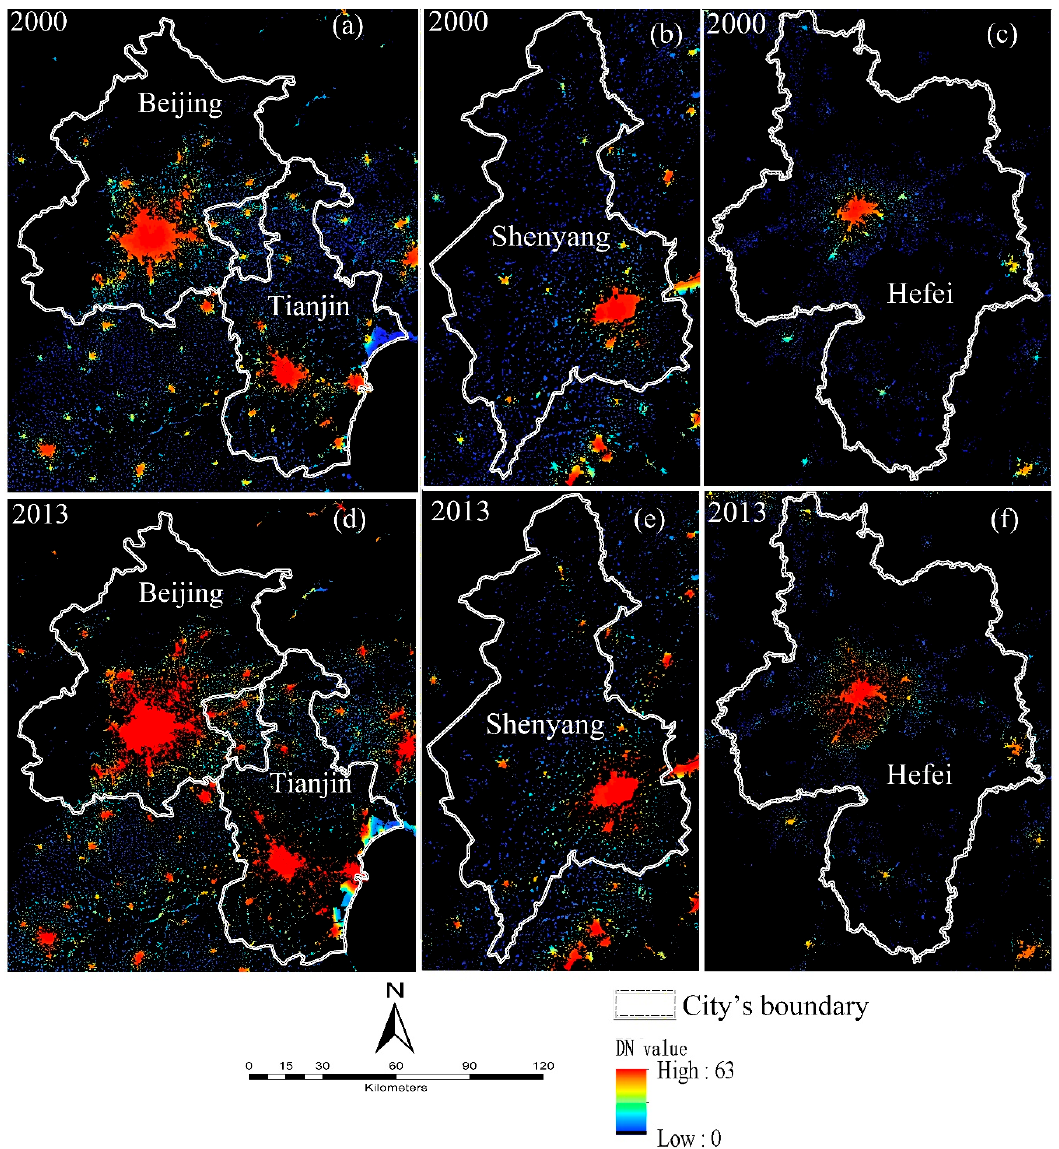
Figure 6. The changing DN values of the three sub-categories of lit areas highlighting the spatial extent of the lit area within the boundary of representative cities ( a , d ) Beijing, ( b , e ) Shenyang, and ( c , f ) Hefei in 2000 and 2013, respectively.